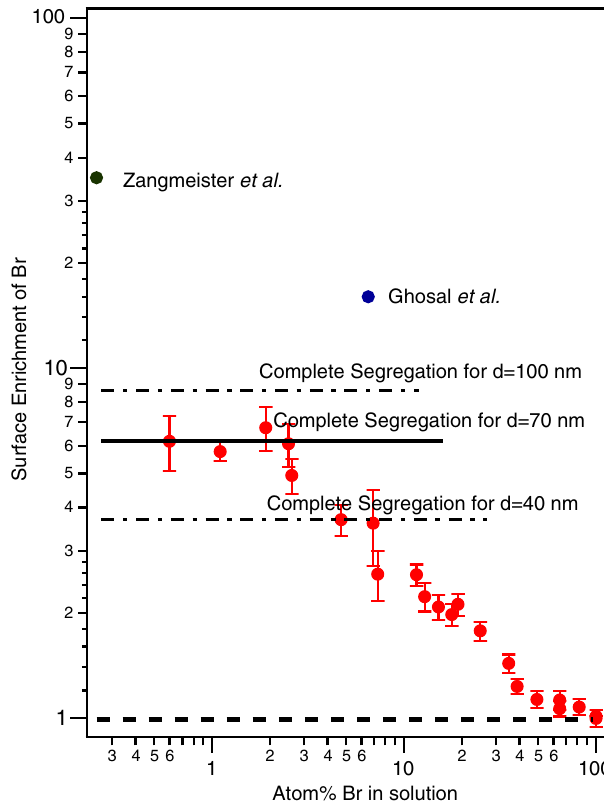
FIG. 4. Surface excess of bromide compared for different NaCl = NaBr mixing ratios in the aqueous droplets. The horizontal full line represents maximal bromide enhancement for complete surface segregation in d ¼ 70 -nm solid aerosols. The observed surface enrichment below 2% for d ¼ 70 nm is in good agree- ment with the value expected for complete segregation. For comparison, the dash-dotted lines indicate the surface enhance- ment expected for complete bromine segregation in d ¼ 40 -nm and d ¼ 100 -nm solid aerosols. The bromide surface excesses found by Zangmeister et al. [20] and Ghosal et al. [22] on larger crystals are also indicated. Because of the very low surface/bulk ratios in large crystals, the bulk serves as a quasi-infinite reservoir of bromide in such extended crystals, allowing higher surface excesses than can be reached in nanometer-scale aerosols. The broken line indicates the bromide surface concentration in the absence of surface